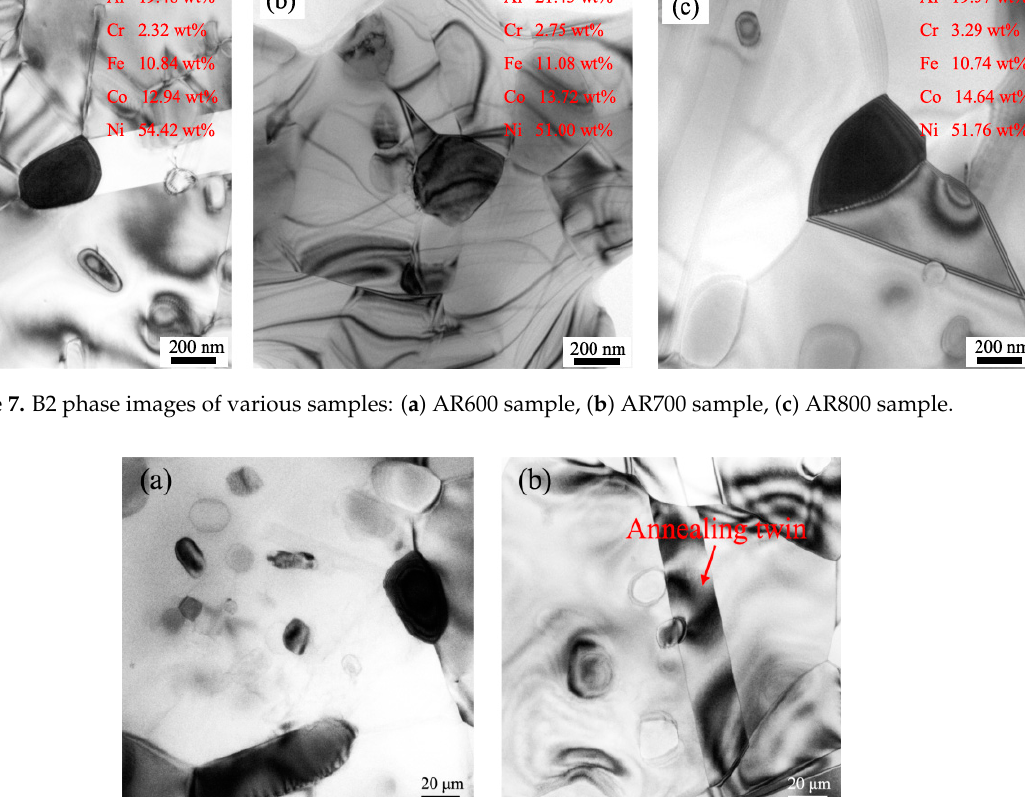
Figure 8. TEM images of AR800 sample. ( a ) B2 phases at grain boundaries and within grains; ( b ) B2 phases at twin boundaries.